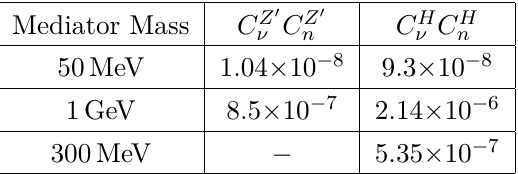
in the MB final state. The mass of N 2